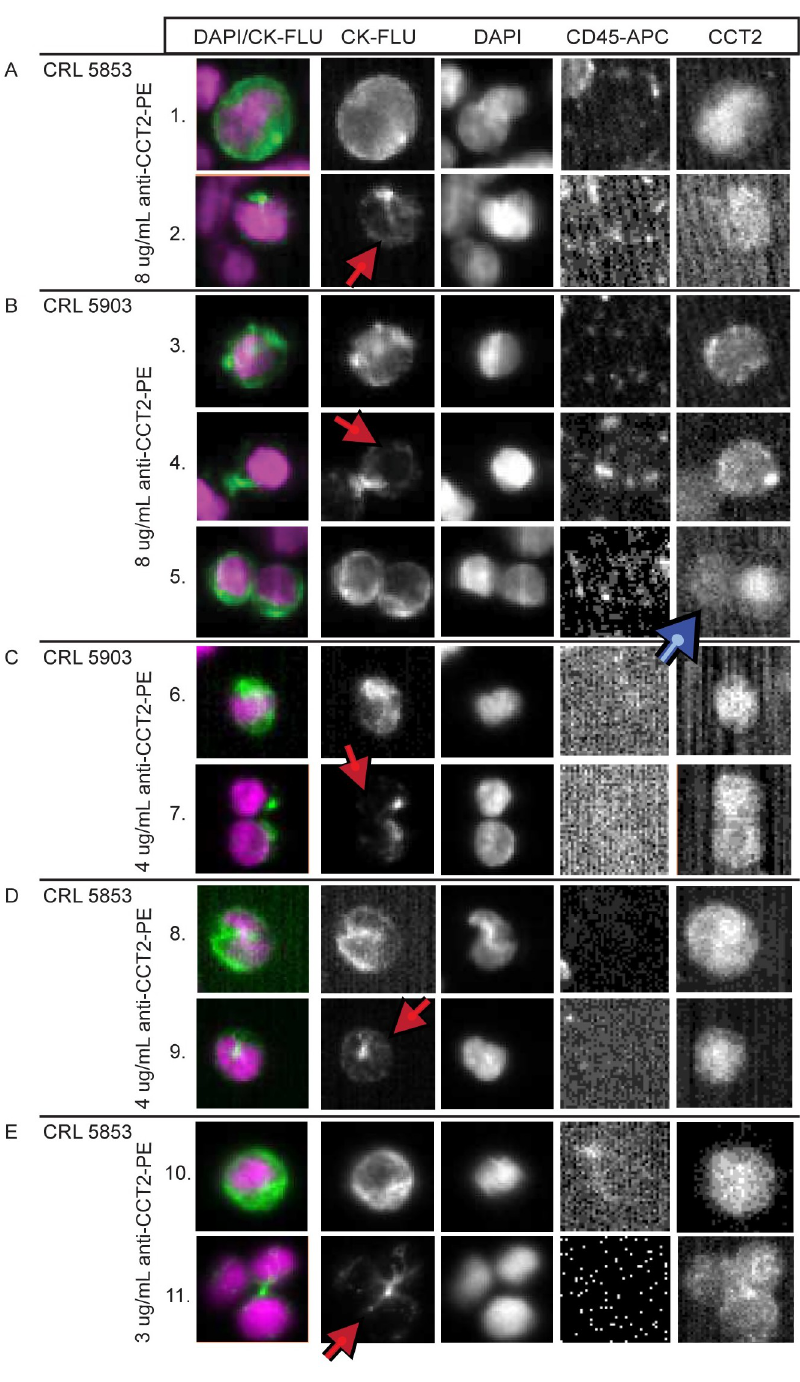
Fig 6. CCT2 staining in lung cancer cell lines. (A-B) Representative images from CSS Analyzer II show SCLC cells spiked into healthy human blood and processed with the CSS Autoprep using the anti-CCT2-PE antibody. (A) CRL 5853 and (B) CRL 5903. Red arrows: cells that have dim CK and are CCT2 positive. Blue arrows: doublet of spiked cancer cells with different CCT2 staining intensities. The experiment was performed in duplicate. (C-E) Representative images of lung cancer cells (C) CRL 5903 and (D-E) CRL 5853, stained with reduced anti-CCT2 antibody as indicated in Methods. Red arrows: cells with dim CK staining and CCT2 positive staining. CK-FLU.